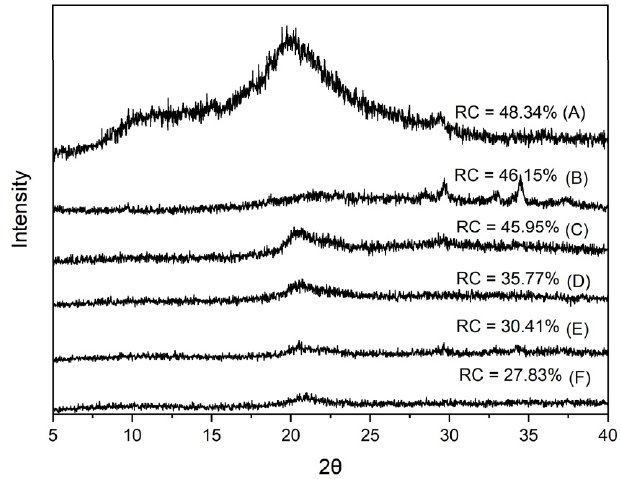
Figure 10. X-ray diffraction pattern of: ( A ) raw chitosan, ( B ) without surfactant, ( C ) with span 80 addition, ( D ) with span 20 addition, ( E ) with tween 80 addition, ( F ) with tween 20 addition. The chitosan concentration, surfactant concentration, and reaction time were 1% ( w / v ), 7% ( w / w ), and 24 h, respectively.